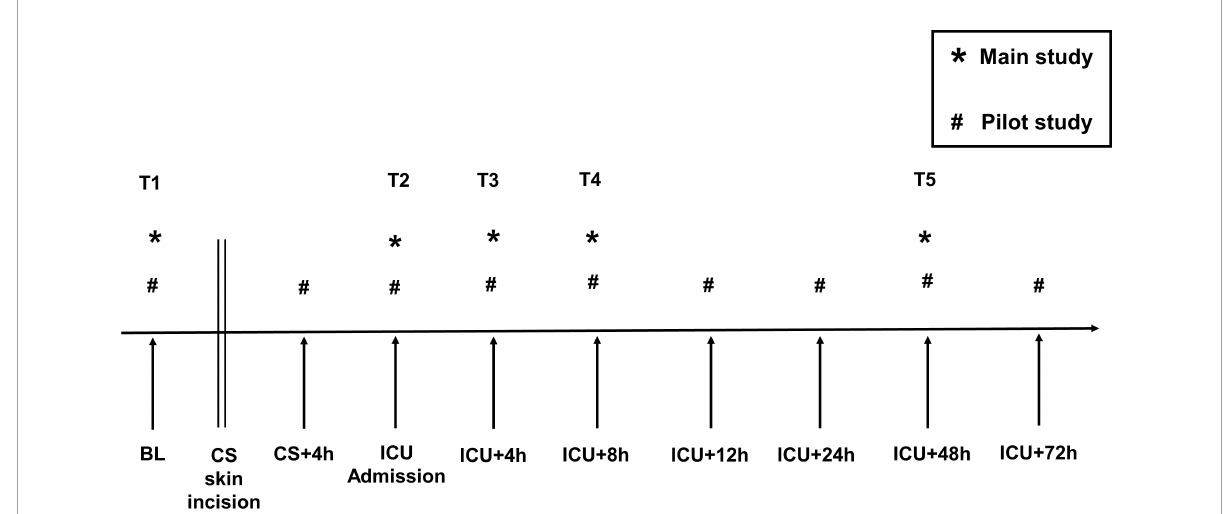
FIGURE2 Blood sampling timeline. T1–T5, blood sampling time points used for statistical analysis. BL, Baseline; CS, cardiac surgery; CS + 4 h, 4 h after skin incision; ICU, intensive care unit. *, main study; #, pilot